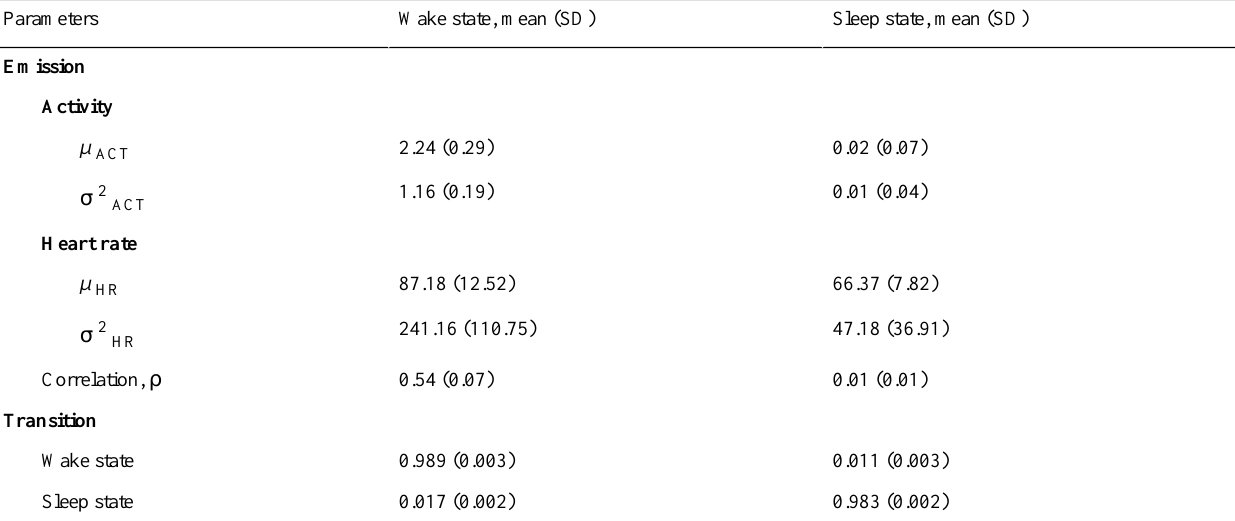
Table 3. Mean estimated HMM parameters for the sample of